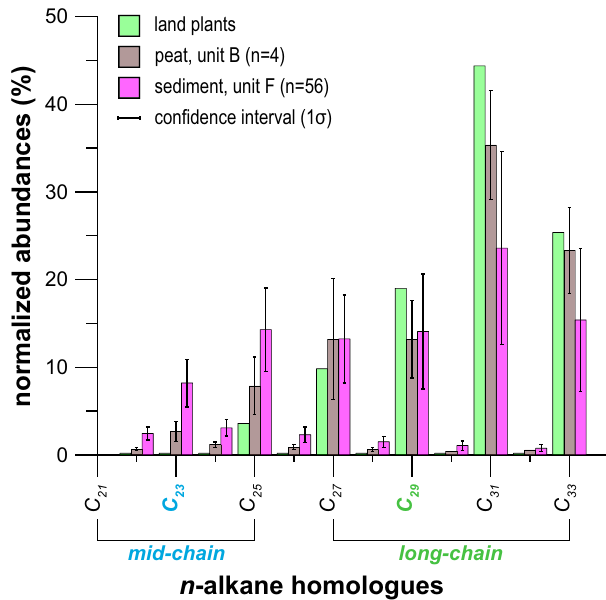
Fig. 4 Chain-length distributions. The abundance of n -alkane homologs in terrestrial plants collected in South Georgia by ref. 54 , and sediment and peat samples from the investigated archive from Lake Diamond (LDP2). We distinguish between mid- and long-chain compounds after the de fi nition by ref. 49 in color coding that corresponds with Figs. 3, 5, 6. Con fi dence intervals are based on down-core variations of LDP2 samples (see Fig.